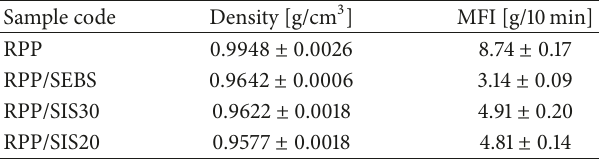
Table 4: Density and MFI values for RPP/elastomer compounds and unmodified